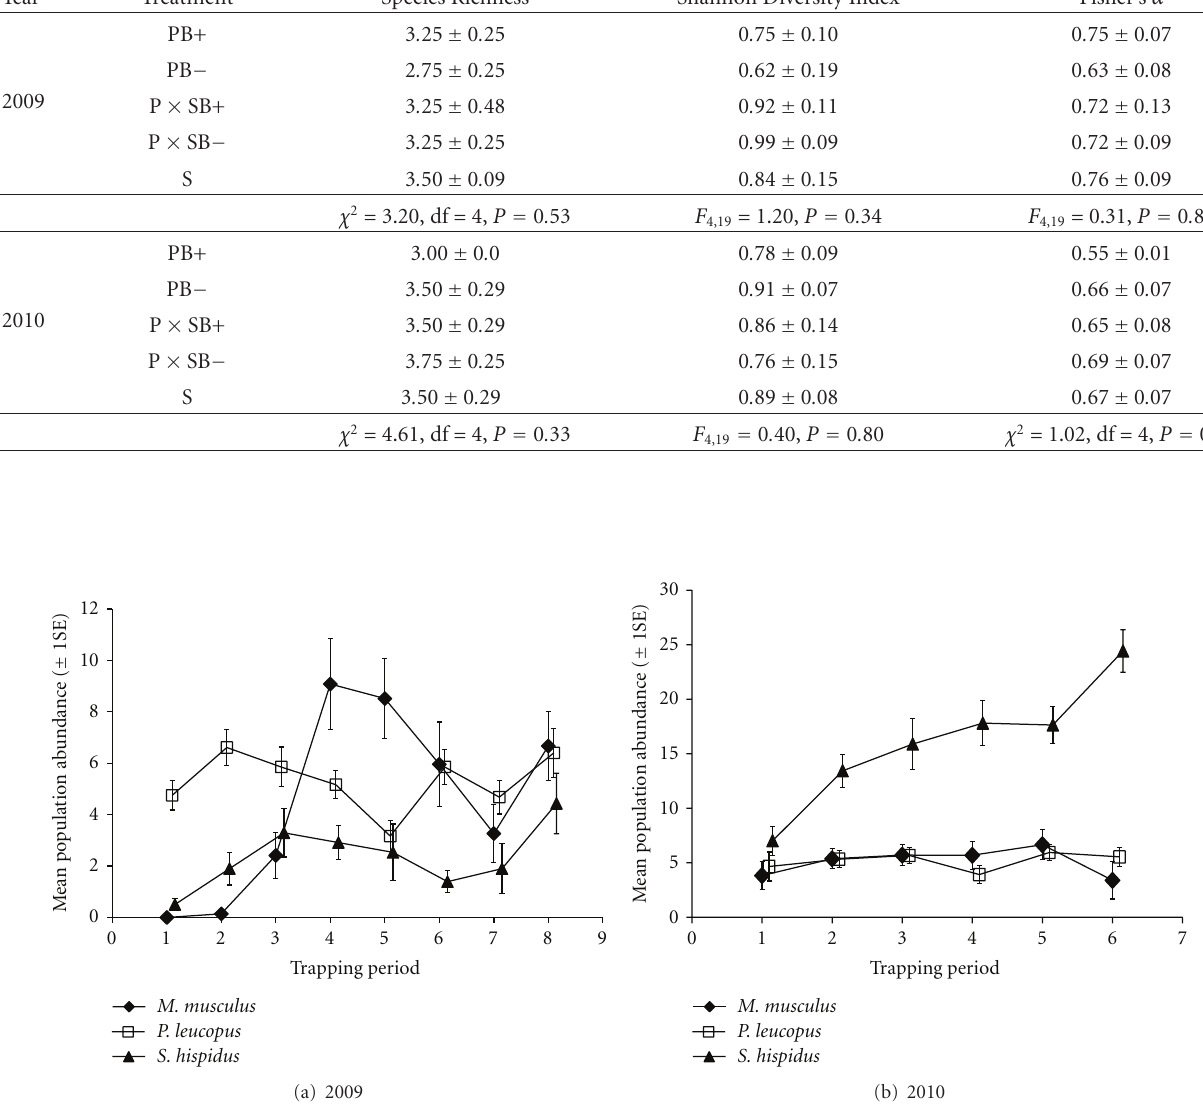
Figure 3: Population abundance (mean abundance ± 1 standard error; n = 4) for Mus musculus, Peromyscus leucopus, and Sigmodon hispidus by trapping period in (a) 2009 and (b) 2010 at the Lenoir 1 Sustainability Study Site, in Lenoir Co., NC. Axes vary between plot (a) and (b) to improve readability. Although not shown, 18 Reithrodontomys humulis were captured in 2009: 1 in period 2 (P2), 3 in P3, 2 in P4, 2